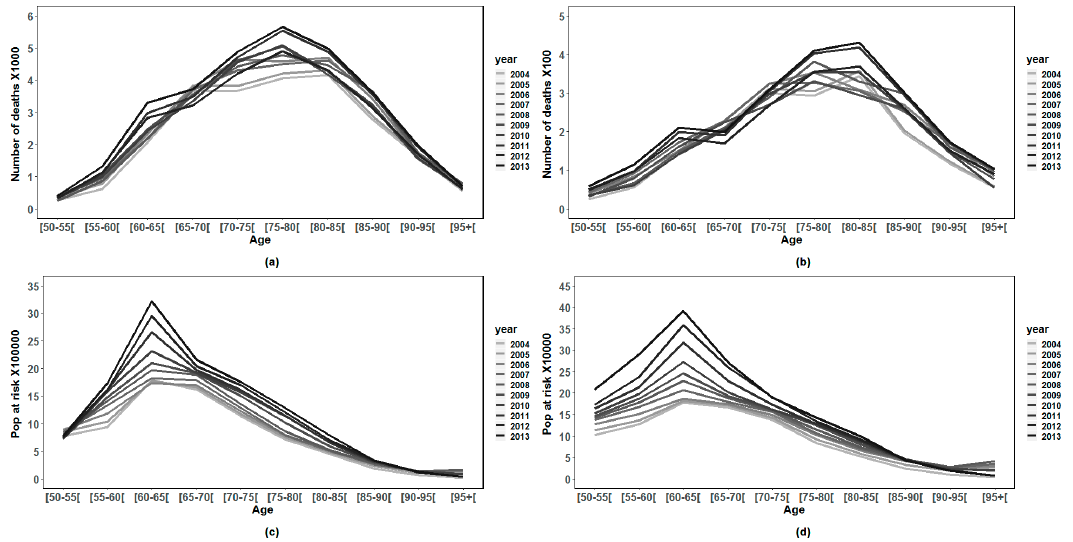
Figure 1 . Deaths and population at risk by age and sex: ( a , b ) the observed number of deaths and its evolution over age for males and females, respectively; and ( c , d ) the population at risk by age for males and females, respectively. Data Source: CNR.